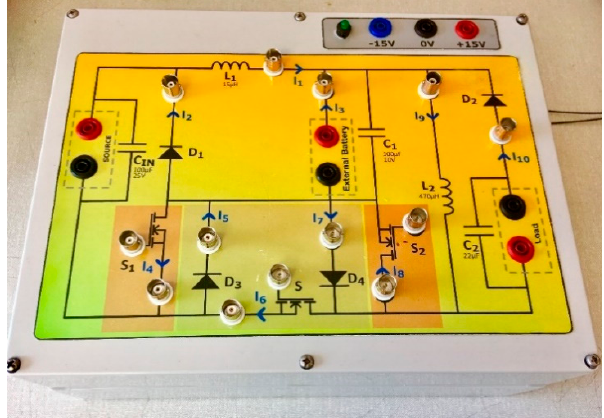
Figure 12. Experimental setup for the two buck/buck ‐ boost equivalent circuits.